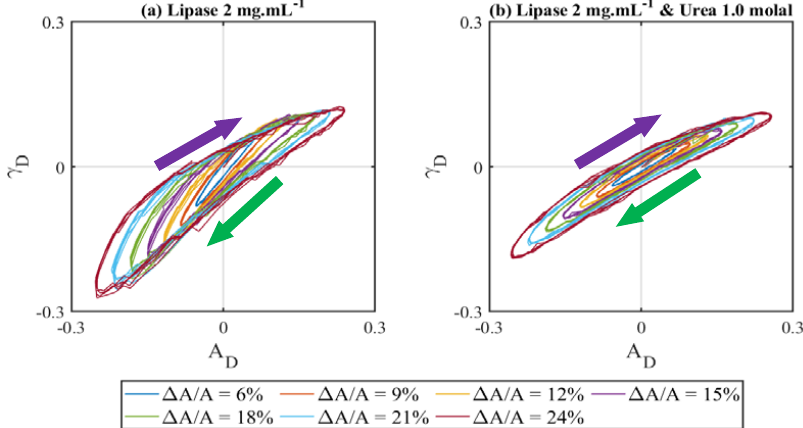
Figure 8. The effect of amplitude sweep on the Lissajous plot of aged adsorbed layers for 5.2 h of 2 mg · mL − 1 lipase solutions without and with 1 molal urea; the compression and expansion paths are denoted with green and purple arrows, respectively; ∆ A / A for Lissajous plots from inside towards outside are 6% (blue), 9% (orange), 12% (yellow), 15% (purple), 18% (green), 21% (light blue), and 24% (red), respectively; solid lines are used for better visualization of experimental results.